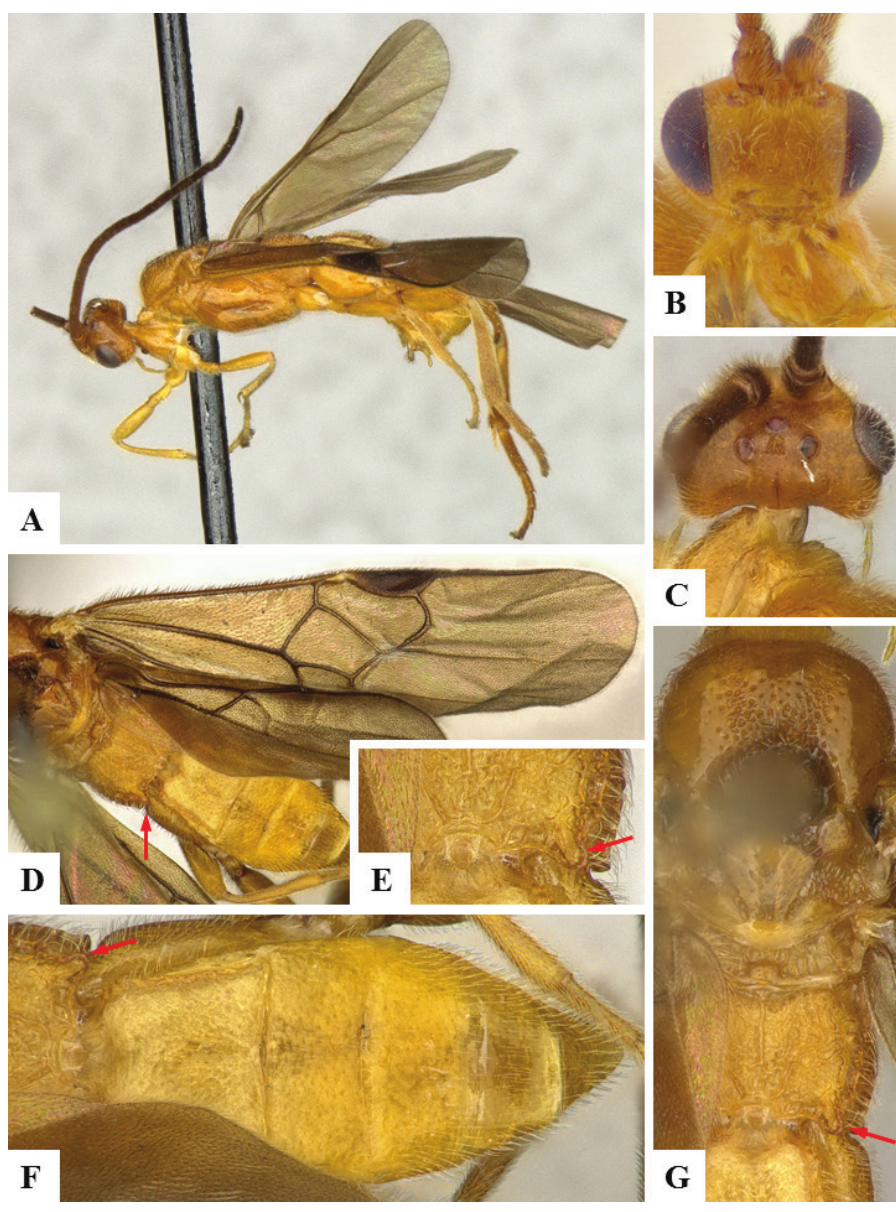
Figure 33. Qrocodiledundee outbackense male holotype. A Habitus B Head frontal C Head dorsal D Fore wing E Pronotum F Metasoma dorsal G Mesosoma dorsal. Red arrow shows the propodeal apophysis. Diagnostic description. Clypeus extremely long and thin (Figs 34B, 35B, F). Ma- lar line extremely short, almost nonexistent (0.01 mm long). Mandible base separate from head by a desclerotized area that looks almost like an opening (Figs 34B,